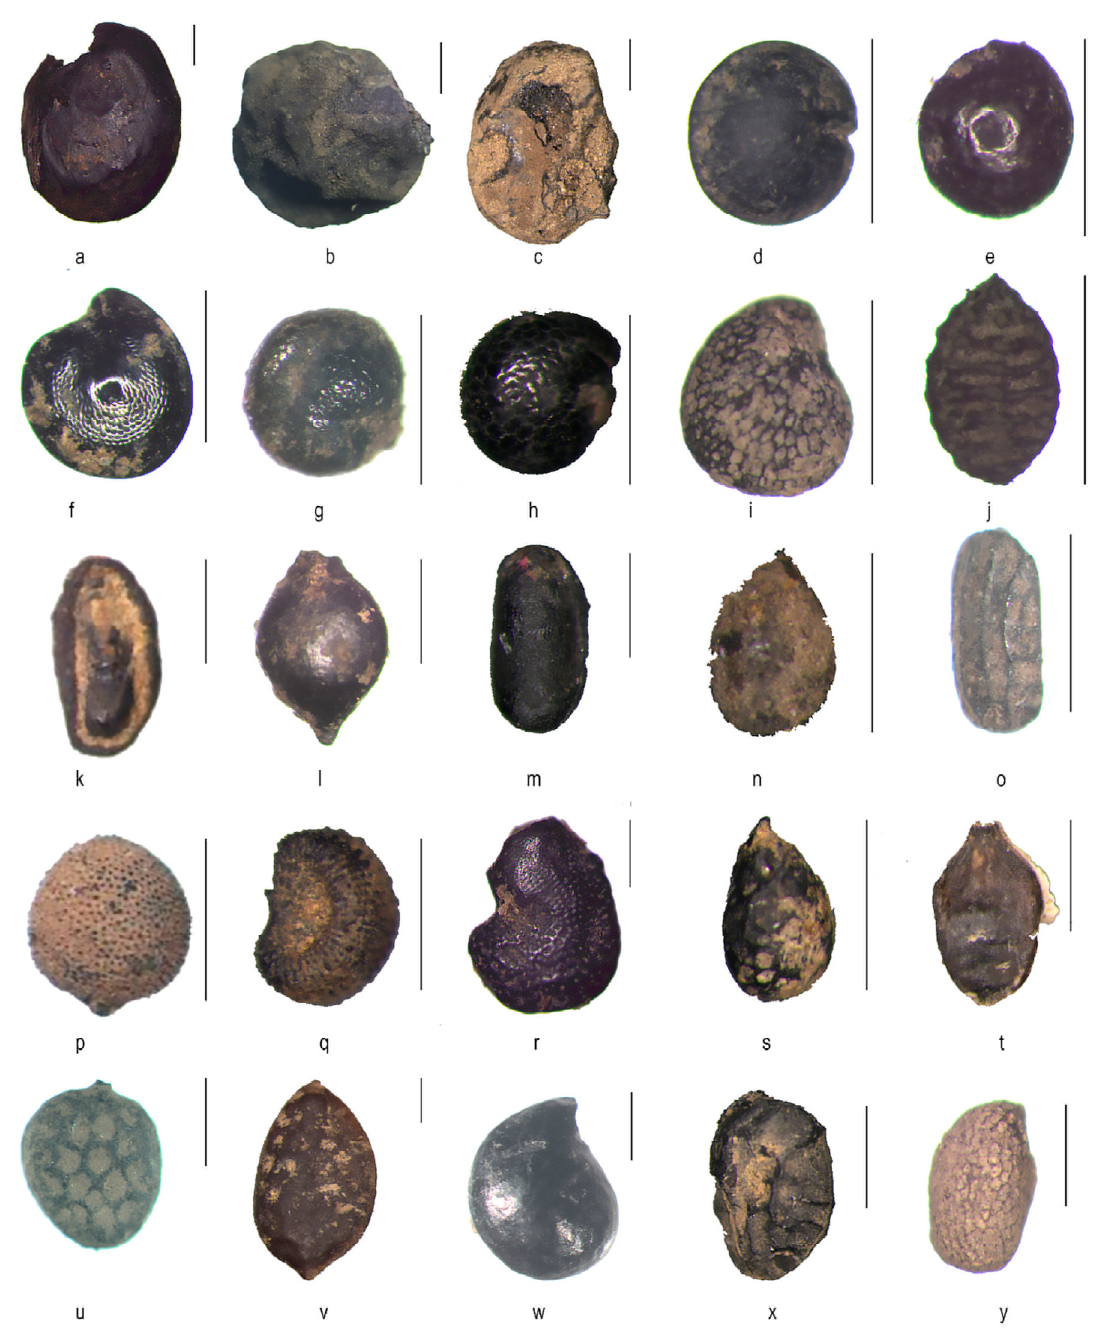
Figure 9. Botanical macroremains recorded in the archeological terraces of Joyagzhí (Scale: 1 mm). Cultivated taxa: ( a ) Zea mays , ( b ) Phaseolus vulgaris , ( c ) Lupinus mutabilis . Adventitious taxa: ( d ) Amaranthus sp., ( e ) Amaranthus spinosus , ( f ) Calandrinia ciliata , ( g ) Dysphania ambrosioides , ( h ) Chenopodium petiolare , ( i ) Nicandra physalodes , ( j ) Oxalis latifolia , ( k ) Plantago linearis , ( l ) Rumex andinus , ( m ) Trifolium Amabile , ( n ) Urtica leptophylla , ( o ) Verbena litoralis , ( p ) Vicia andicola . Ruderal taxa: ( q ) Arenaria lanuginosa , ( r ) Armatocereus godingianus , ( s ) Cavendishia bracteate , ( t ) Cyperus aggregatus , ( u ) Passiflora ampullacea , ( v ) Passiflora sp., ( w ) Phytolacca rivinoides , ( x ) Rubus roseus , ( y ) Vaccinium sp. Concerning the ecological groups, adventitious plants are most conspicuous among the RDP taxa, evincing the greatest number of macroremains (N = 78, or 24% of the total). Cultivated and wild plants likewise proved relatively conspicuous (totaling 65 specimens